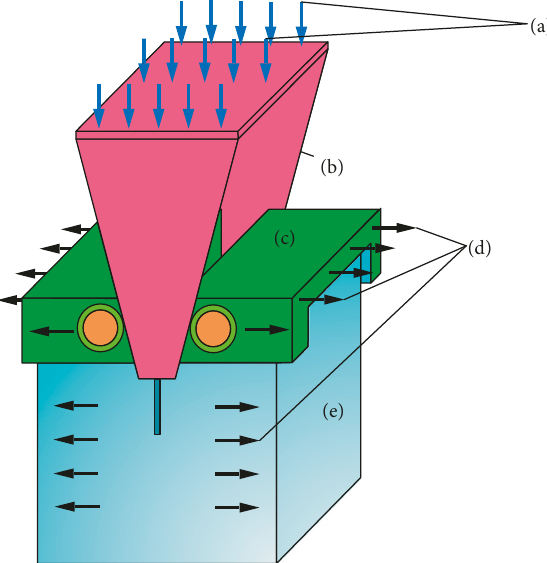
Figure 5: Loading manner of wedged split tensile test: (a) uni- formly distributed load; (b) vertical pressure transfer device; (c) horizontal pressure transfer device; (d) displacement direction; (e) specimen.